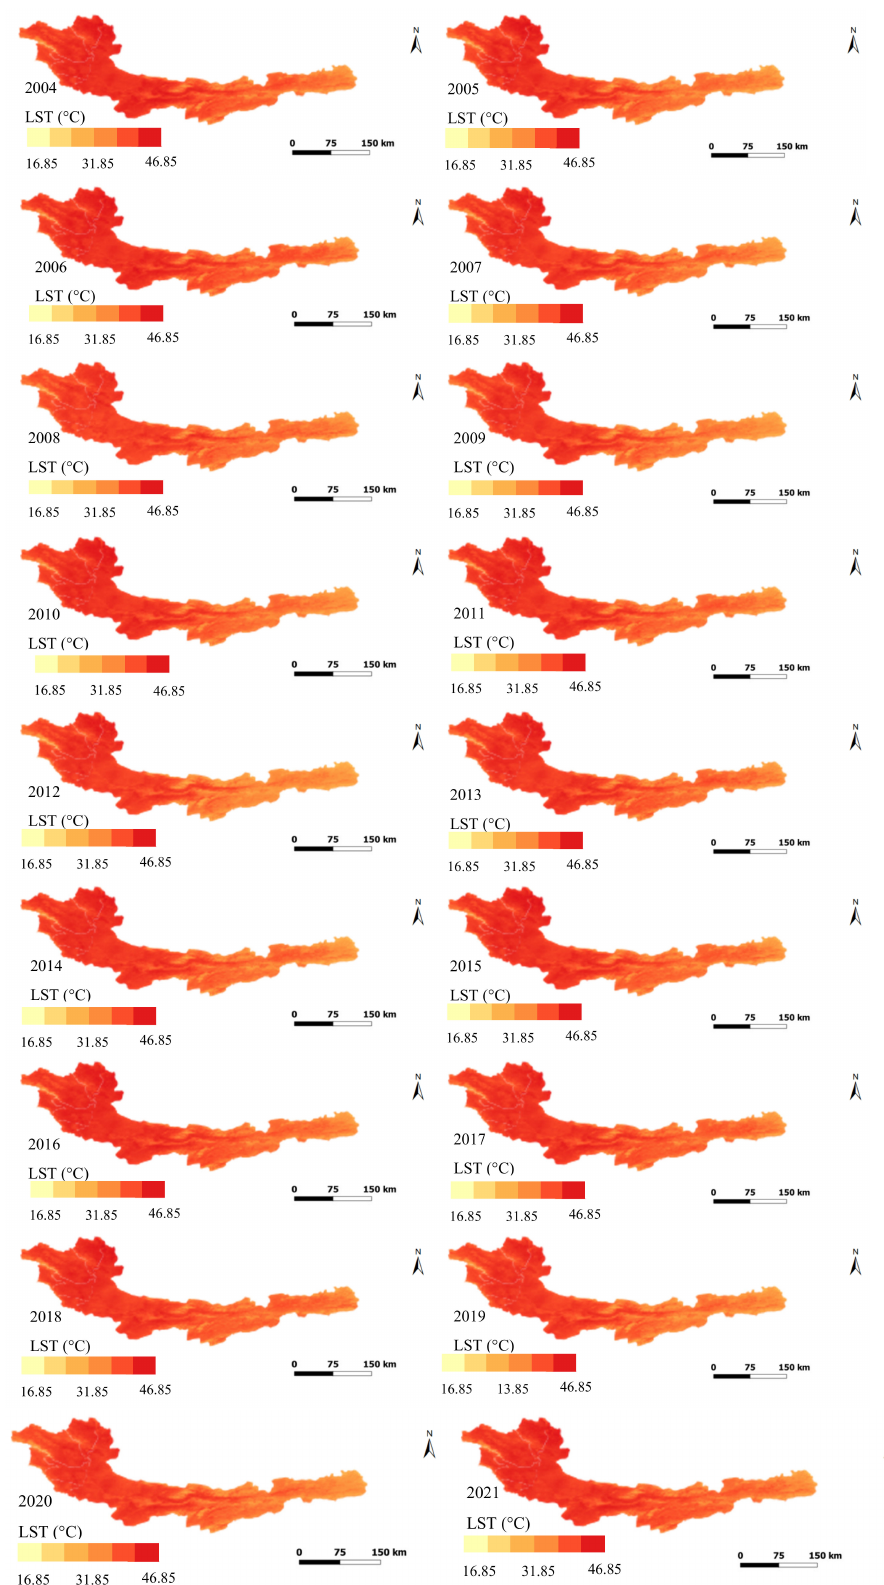
Figure 7. The spatial–temporal distribution of annual land surface temperatures ( ◦ C) from the MODIS (MOD11A1) product derived from GEE in the period of